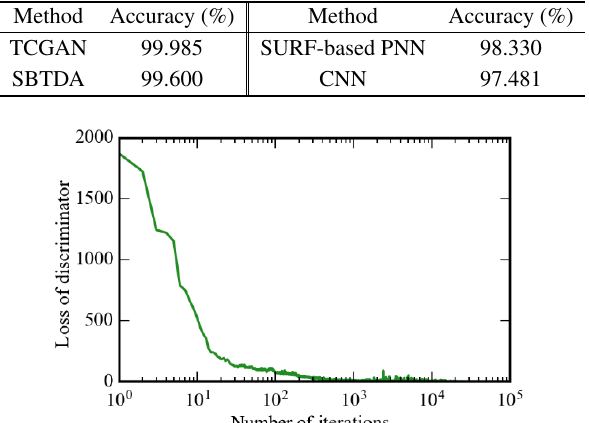
Table 4 Accuracy comparison results with other methods in Case 2.